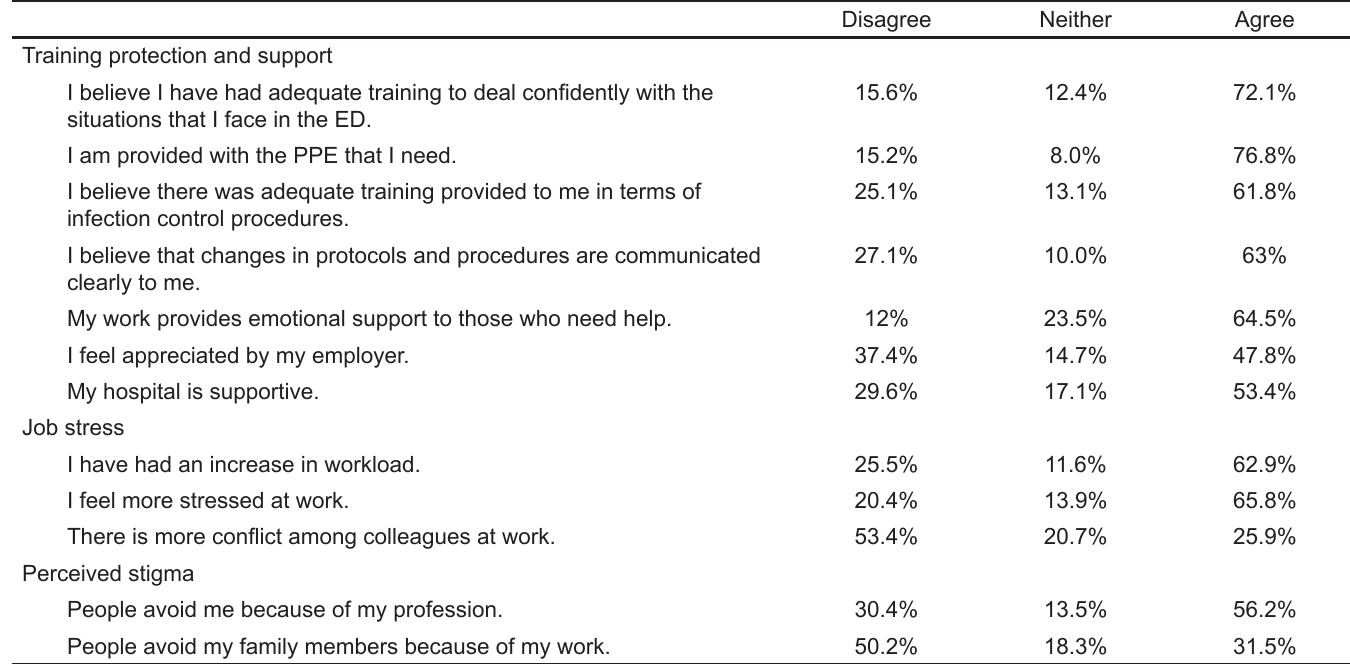
Table 3. Perceived stigma, organizational support, and job